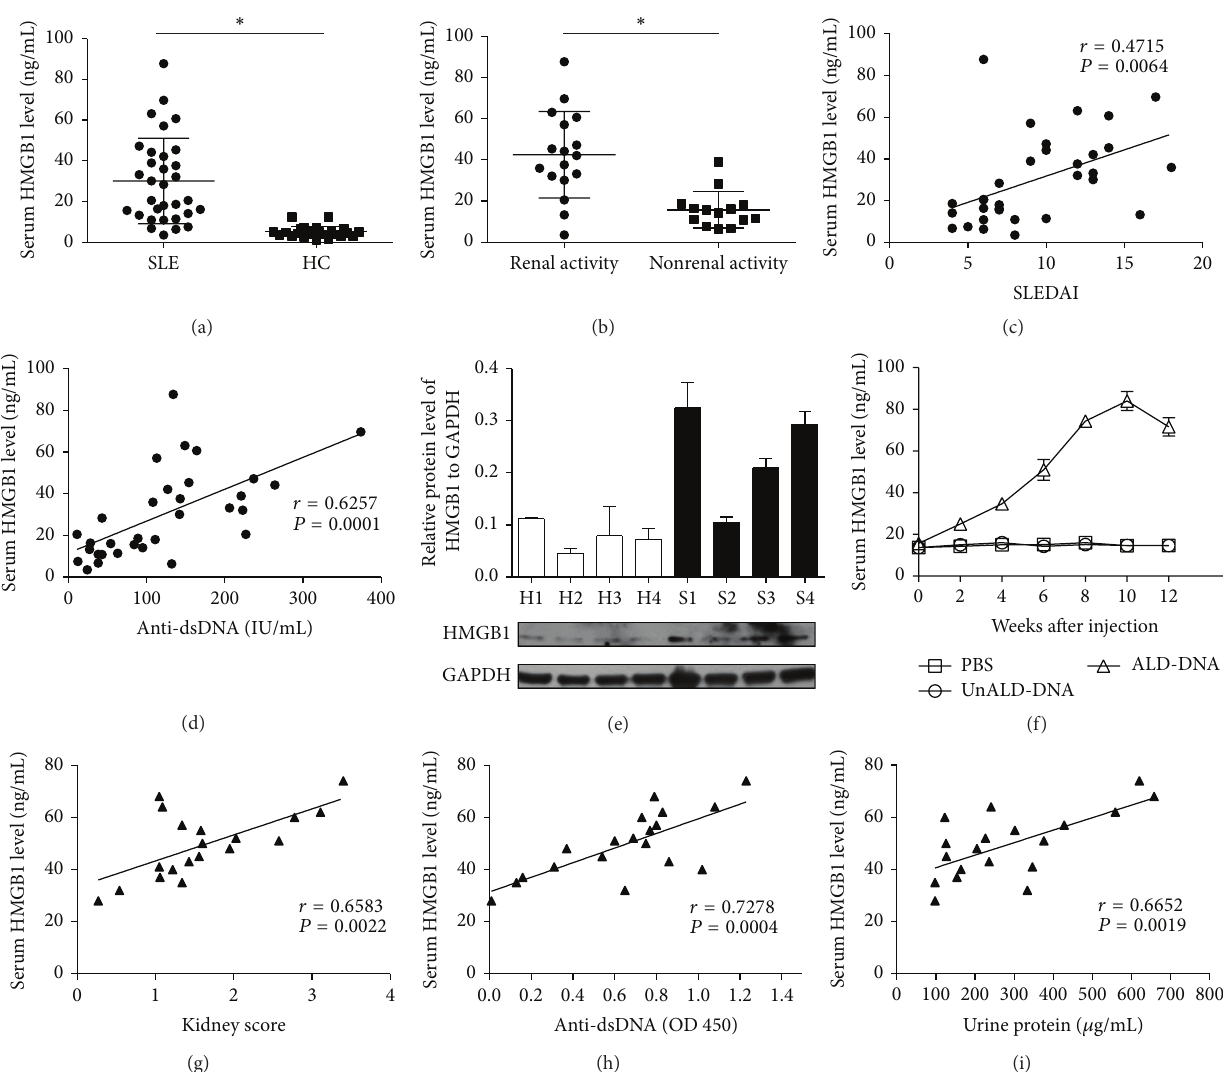
Figure 1: HMGB1 levels were elevated and correlated with SLE disease activity in both clinical patients and murine model. (a) Serum HMGB1 levels were detected by ELISA in SLE patients and HC. (b) HMGB1 levels were measured by ELISA in renal active or inactive patients. The scatter-plot represented the HMGB1 levels by ELISA. Each symbol represents one SLE patient. Horizontal lines represent the median. Data represent the average from experiments performed in triplicates for each patient. (c) Correlation analysis was performed between HMGB1 levels and SLEDAI. (d) Correlation analysis was performed between HMGB1 and anti-dsDNA antibody levels. Pearson correlation analysis was used in the correlation analysis. (e) The expression of HMGB1 was analyzed by western blot in PBMCs from SLE patients (S) and healthy controls (H). Representative western blot bands from 4 patients with SLE and 4 HC were presented. Data were representative of results obtained in three independent experiments. (f) Serum HMGB1 levels were measured by ELISA every 2 weeks after initial injection. Data are means ± SD from 8 mice in each group. (g) The correlation between serum HMGB1 levels and kidney score was carried out in SLE mice. (h) The correlation between serum HMGB1 and anti-dsDNA antibody levels was carried out in SLE mice. (i) The correlation between serum HMGB1 and urine protein levels was carried out in SLE mice. Pearson correlation analysis was used to carry out the correlation study. Each symbol indicates an individual mouse ( 𝑛 = 19 ). ∗ 𝑃 < 0.05